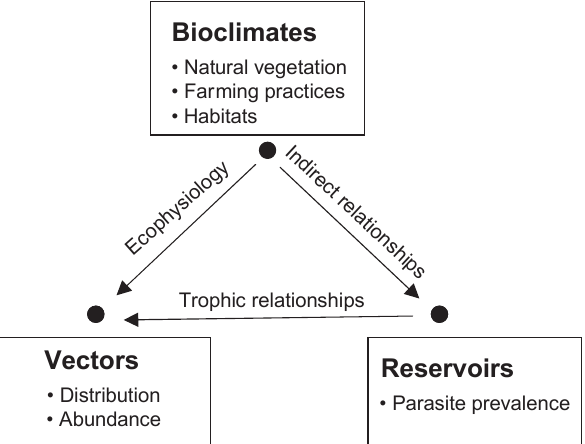
Fig. 2. – Triangular conceptual model of circum-mediterranean leish- maniasis transmission. Bioclimats are revealed from plant species association analysis. Plant associations are correlated to vector dis- tribution and abundance and indirectly determine population reser- voir infection (here dogs or small mammals). After Rioux et al .